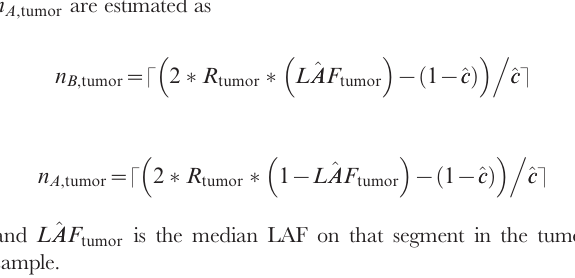
Figure S2 The estimation from SomatiCA helped to increase the accuracy of the inferred copy number inference for SCNAs compared to setting admixture